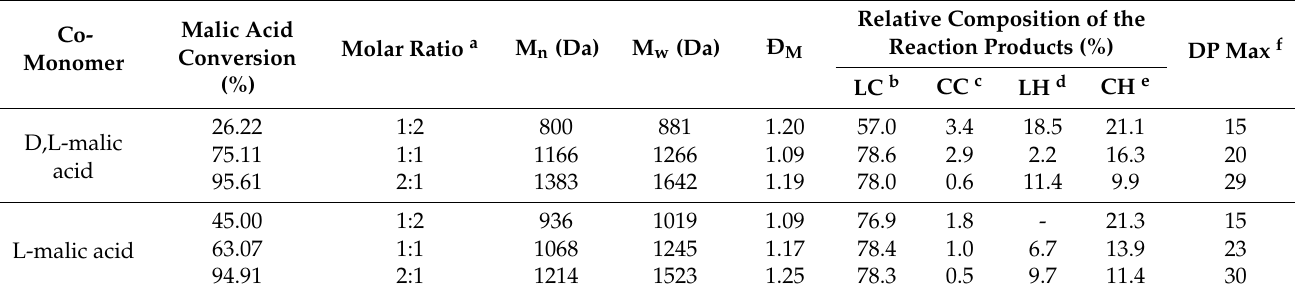
Table 2. Influence of the ECL:MA molar ratio on the composition of the reaction products obtained in the presence of GF-CalB-IM in a solventless